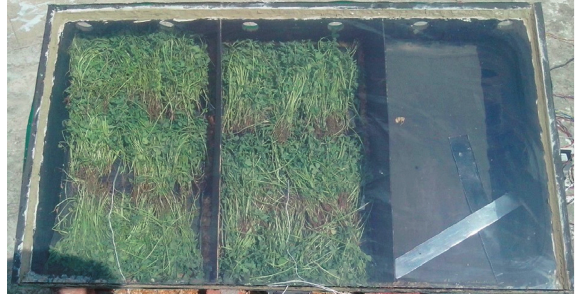
Figure 9: Fenugreek in solar dryer.